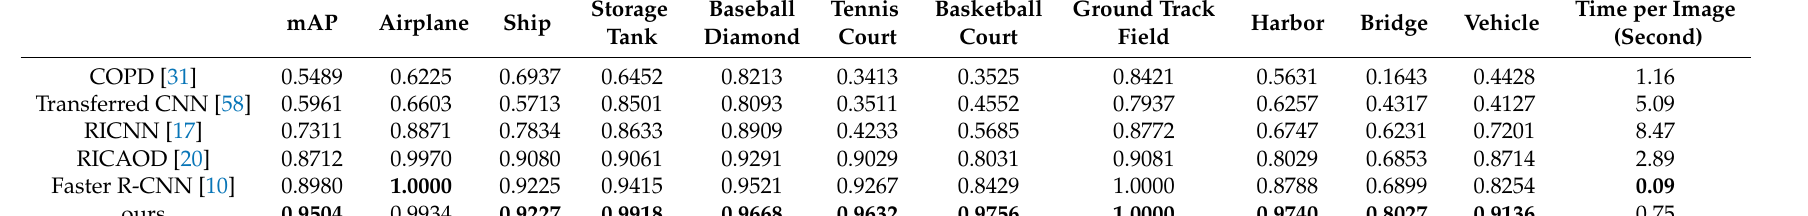
Table 3. Comparison detection results of six different methods.